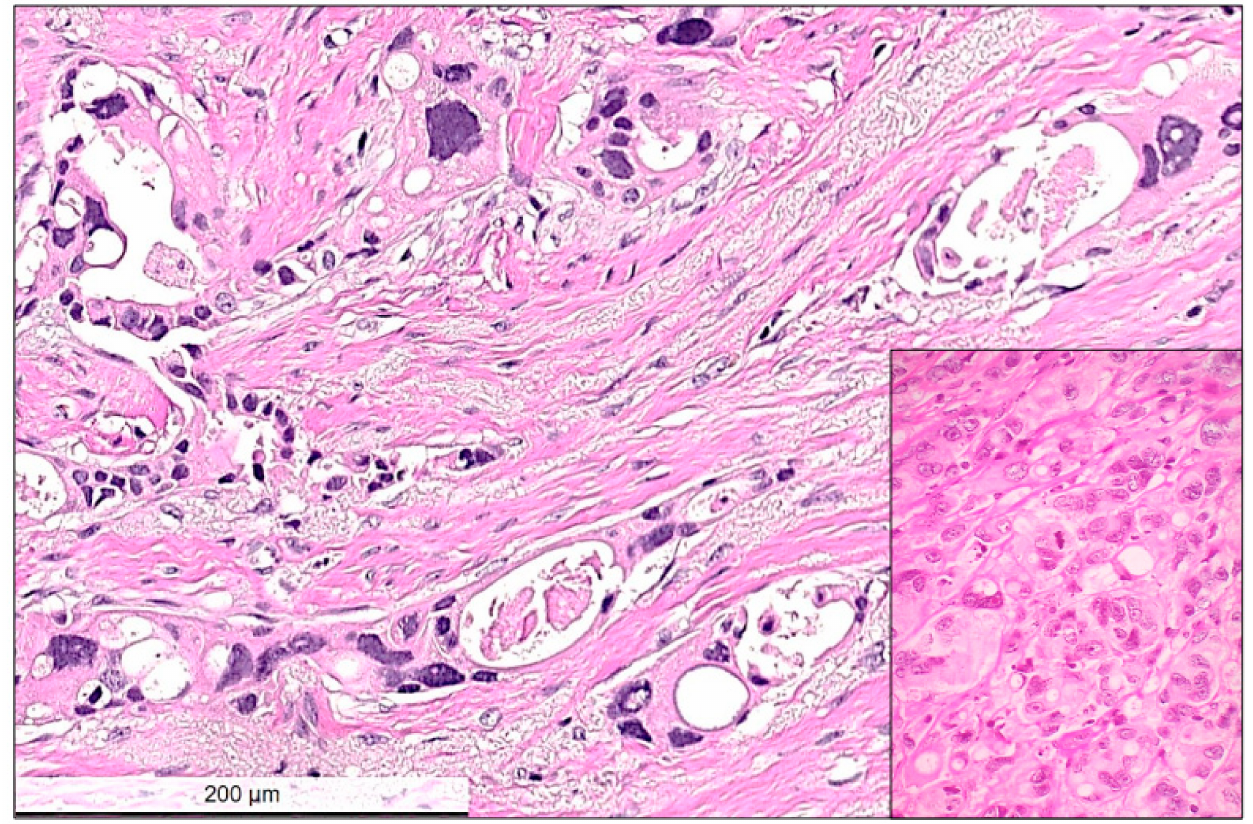
Figure 3. High power view of residual invasive carcinoma cells showing typical cytopathic post- chemotherapy changes, such as multinucleated bizarre cells, nuclear hyperchromasia, nuclear and cytoplasmic vacuolar inclusions. Between the residual carcinoma cells the stroma is loose, edematous corresponding to regression. Inset shows another example with no-response to